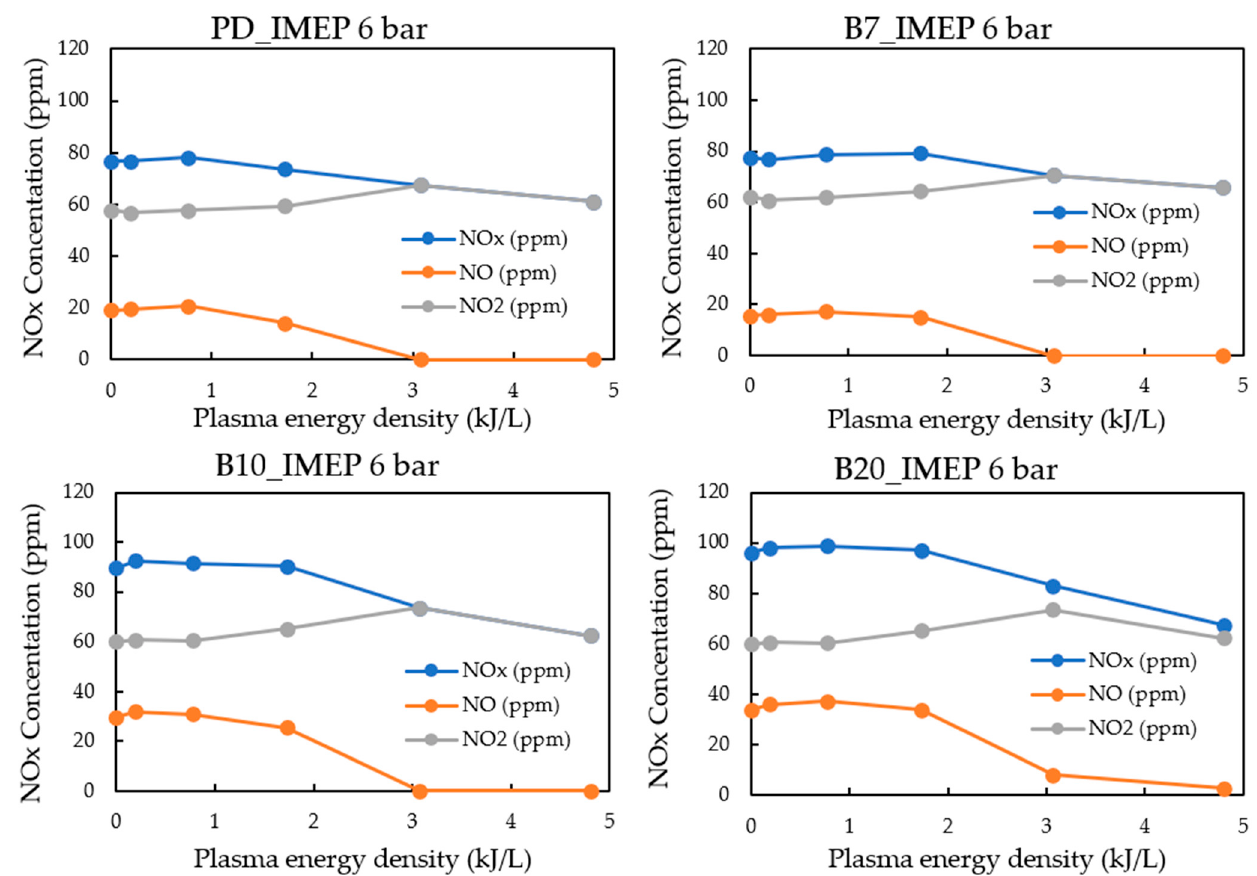
Figure 6. NO, NO 2 , and NOx concentrations after the plasma treatment of energy density .